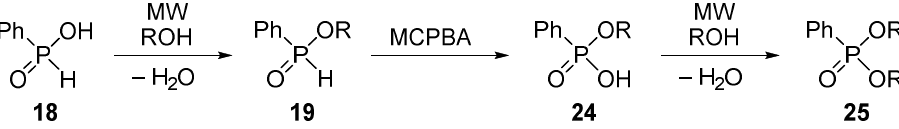
Table 3. MW ‐ promoted direct esterification of phenylphosphonic acid ( 26 ).